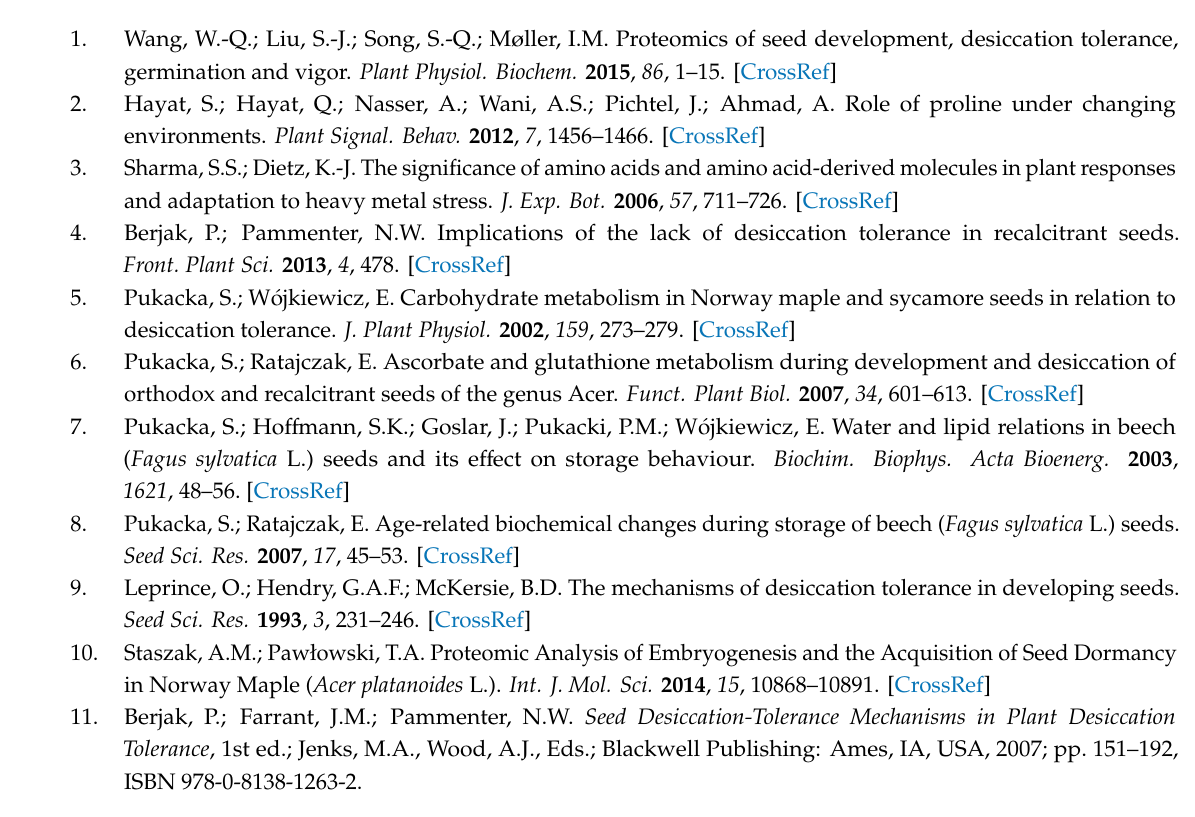
Figure S1: Correlation between proline content an week after flowering in embryonic axes of Norway maple (A); Sycamore maple (A’) and cotyledons of Norway maple (B); Sycamore maple (B’), Figure S2: Anomalies in monthly average precipitation in years 2017, 2018 and 2019 in K ó rnik in relation with reference period 1979–2019. Data obtained from meteorological station at experiment site in K ó rnik, Poland, Figure S3: Anomalies in monthly average temperature in years 2017, 2018 and 2019 in K ó rnik in relation with reference period 1979–2019. Data obtained from meteorological station at experiment site in K ó rnik,